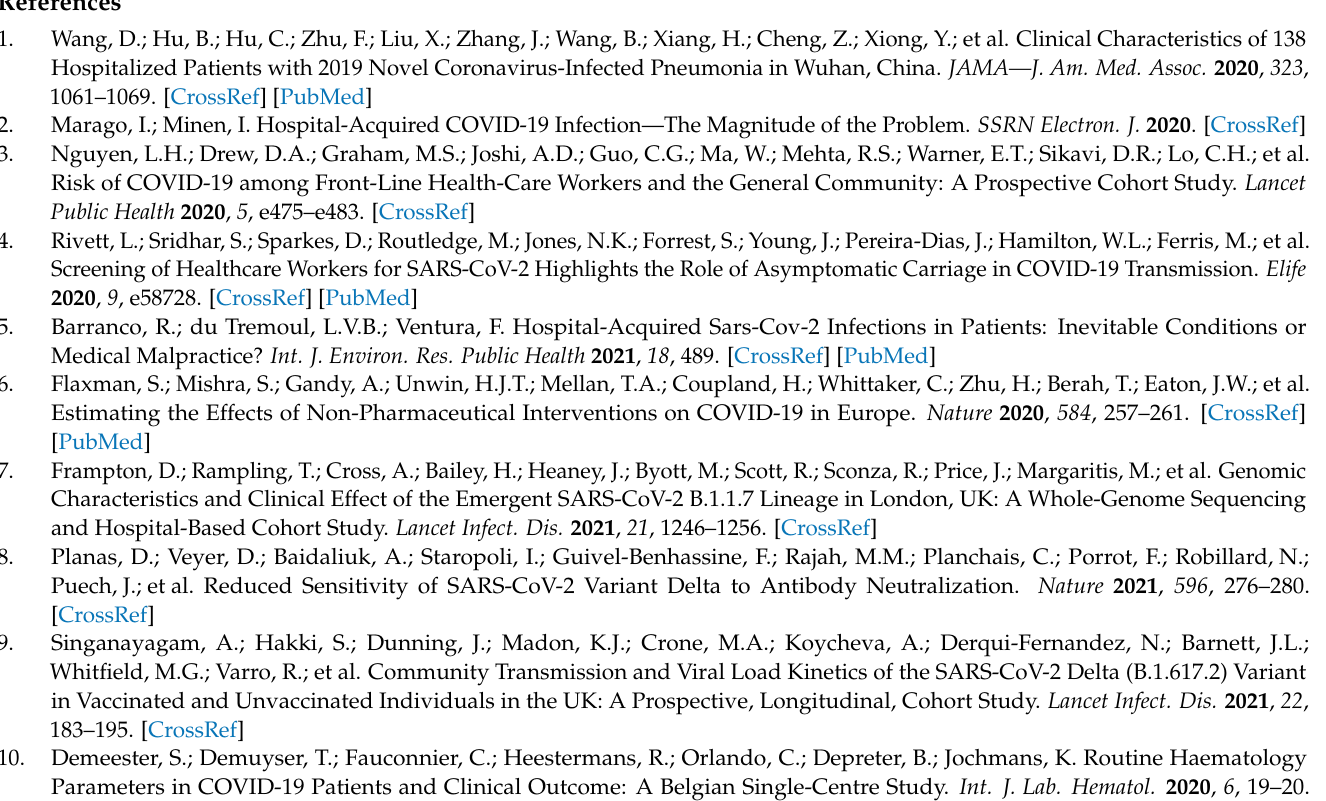
Table S2: Demographic, clinical, and laboratory data of symptomatic healthcare-associated versus Table S3: Hospital-acquired infections according to the ECDC case source definition, Table S4: STATA